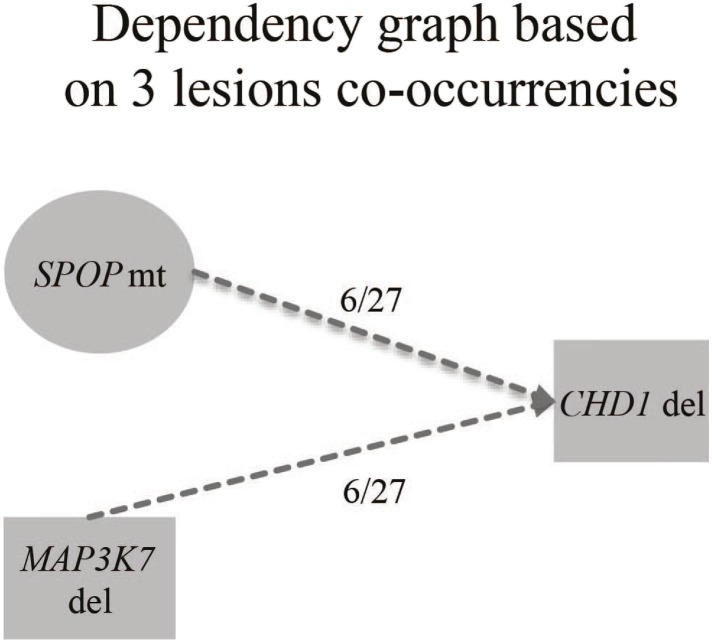
Evolution graphs built from prostate cancer sequencing data.These data were generated based on a previously published algorithm to build tumor evolution paths (Baca et al., 2013; Prandi et al., 2014).